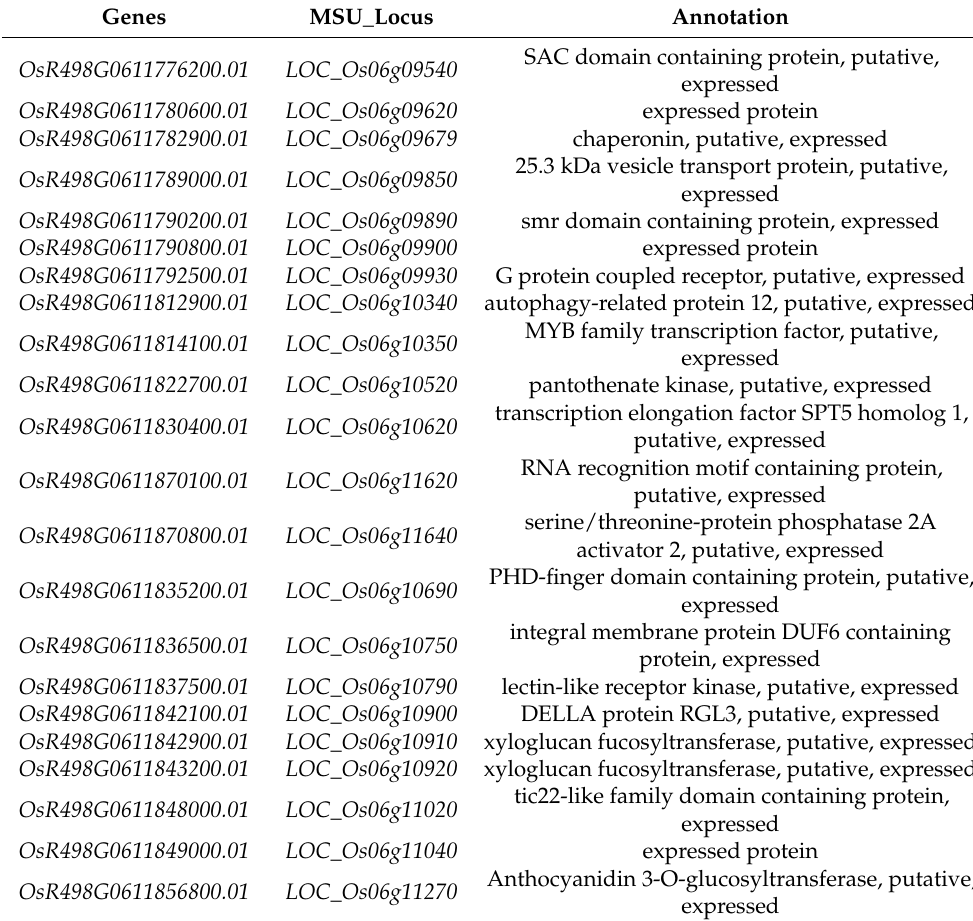
Table 5. Gene annotation of the 27 candidate genes by using Rice Genome Annotation